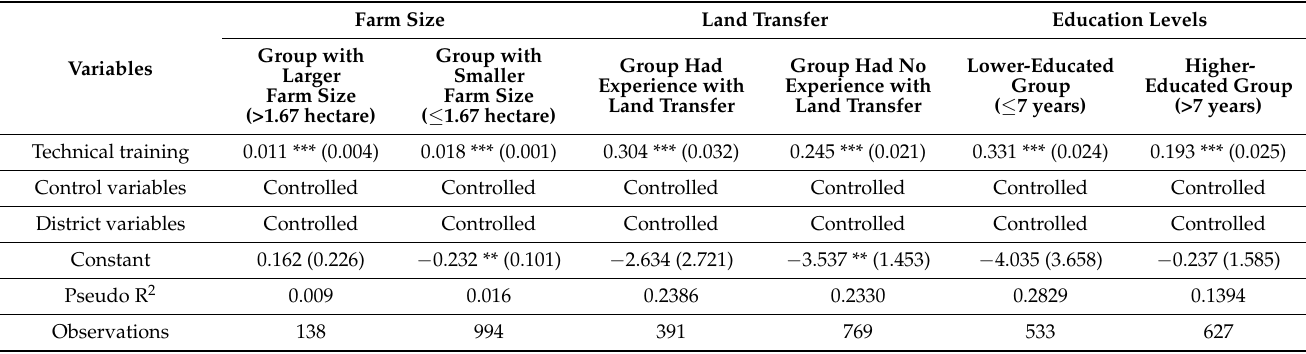
Table 9. Effects disaggregated by groups’ farm sizes, land transfer, and education levels.